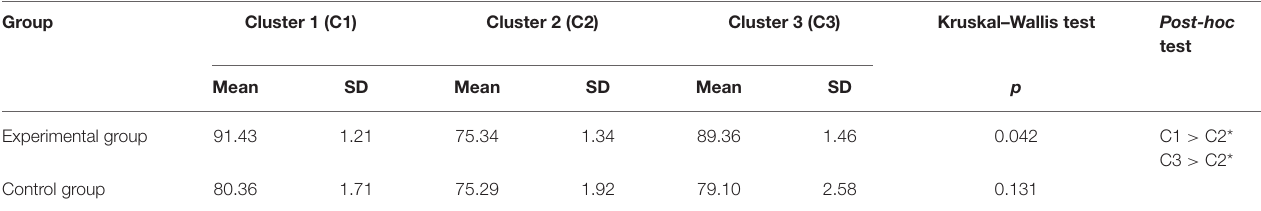
TABLE 4 | Learning achievements among the three clusters.